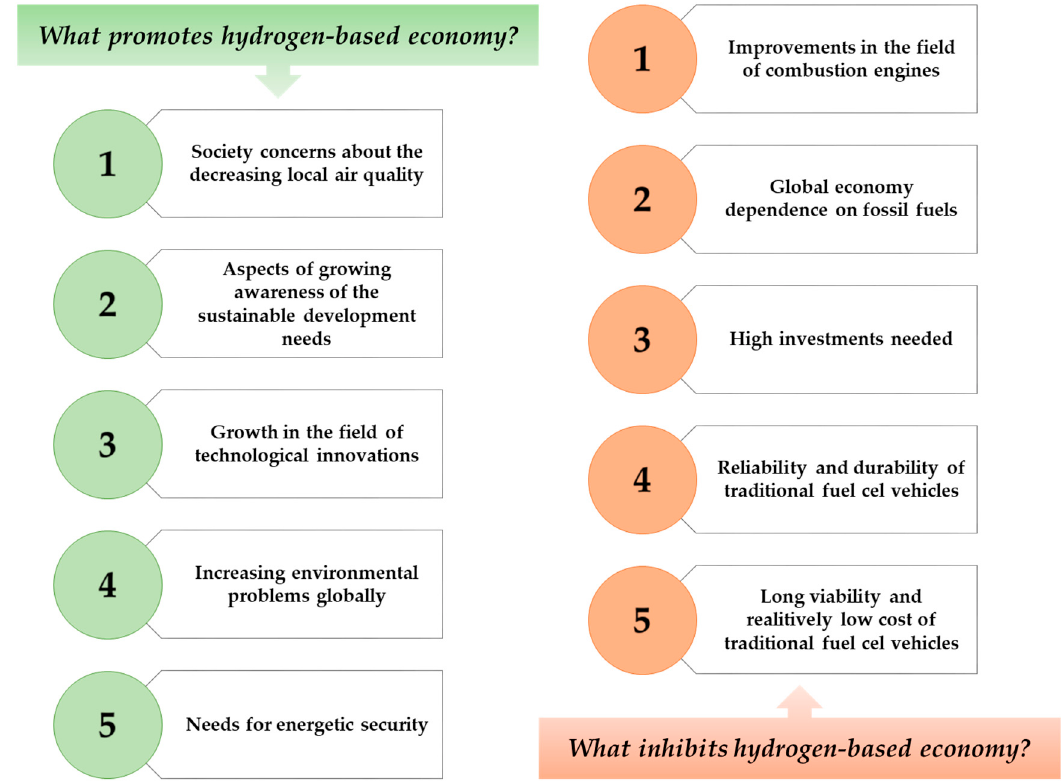
Figure 1. Factors that inhibit and promote the development of hydrogen-based economy.